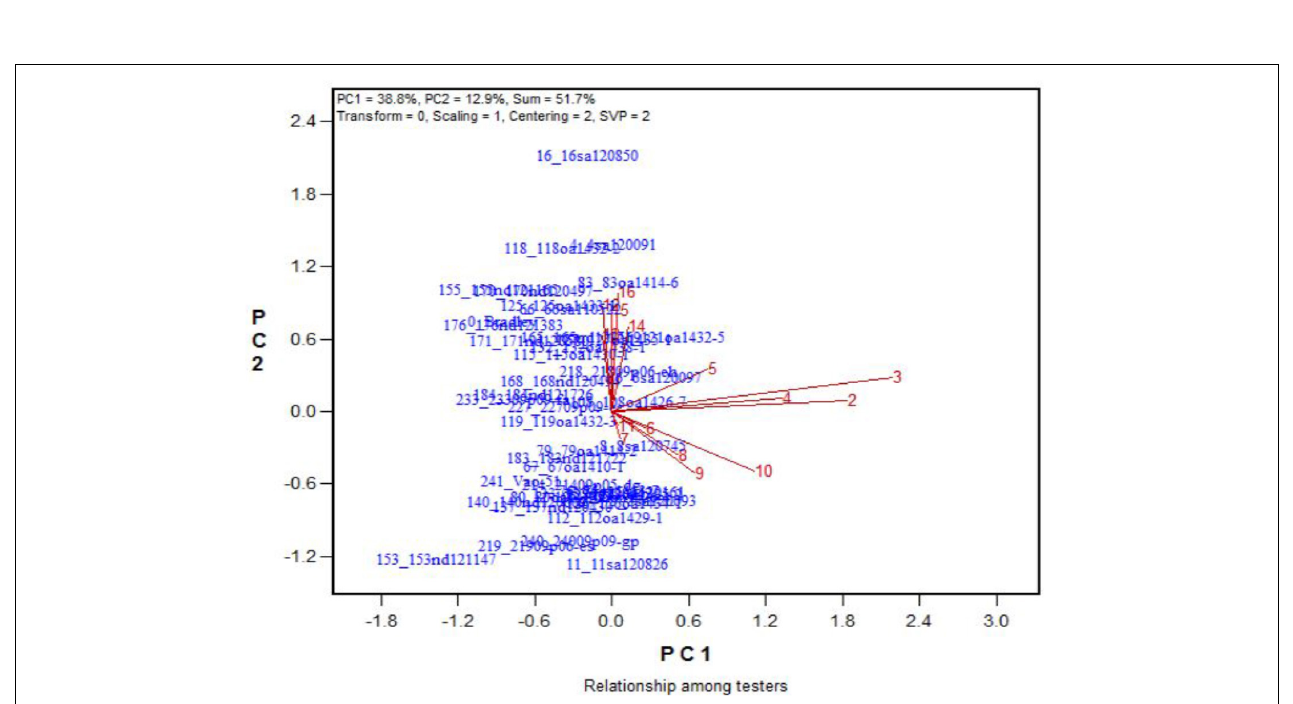
FIGURE 11 | Effects of 16 treatments on the YND leaves for 43 oat genotypes. See descriptions for each treatment in Table 1 . YND leaves = yellow and not dry.